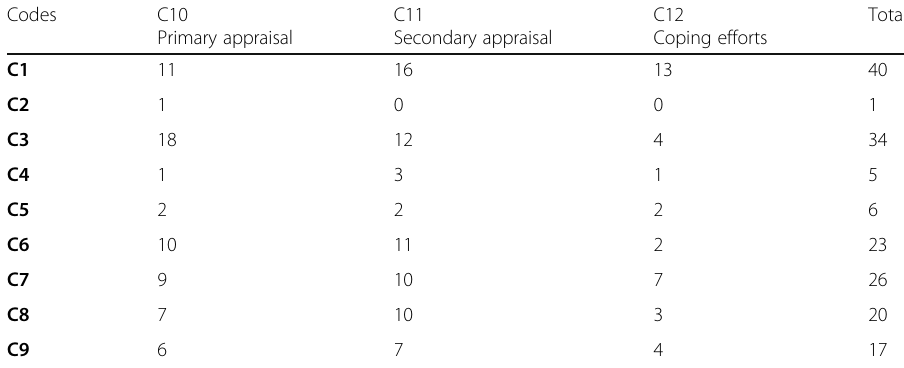
Table 5 Initial codes and secondary codes and their frequencies